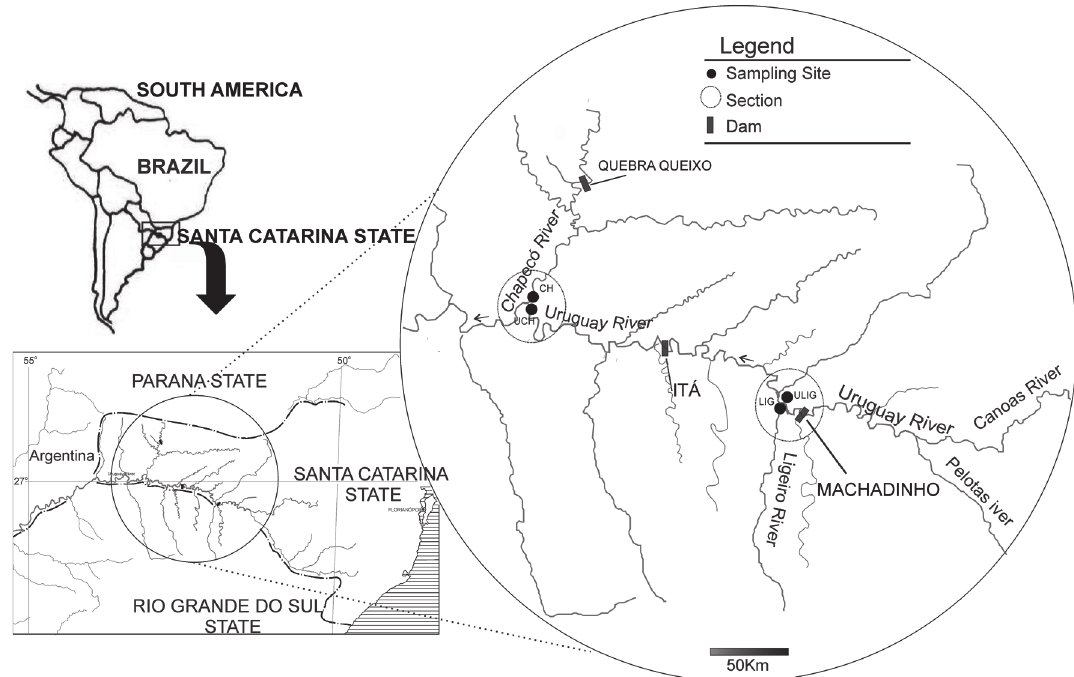
Fig. 1. Location of the sampling sites in the upper Uruguay River in southern Brazil. Samplings sites: LIG: Ligeiro, ULIG: Uruguay-Ligeiro, CH: Chapecó, UCH: